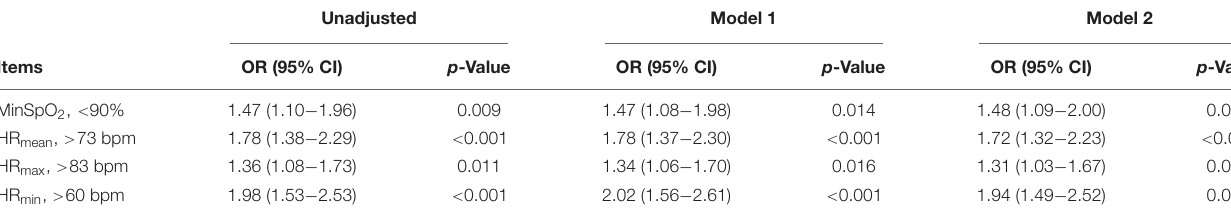
TABLE 3 | Relationship between minSpO 2 and minSpO 2 -specific HR metrics with AMI. Unadjusted Model 1 Model 2